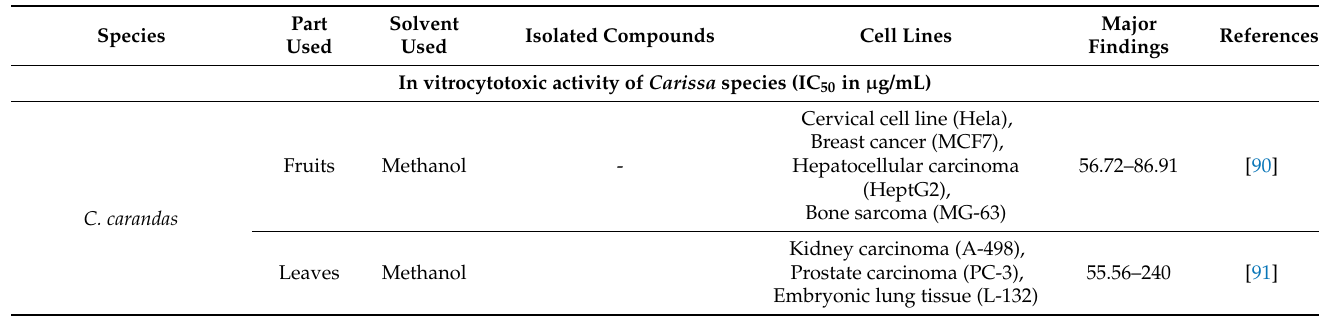
Table 5. In vitro cytotoxic activity of Carissa